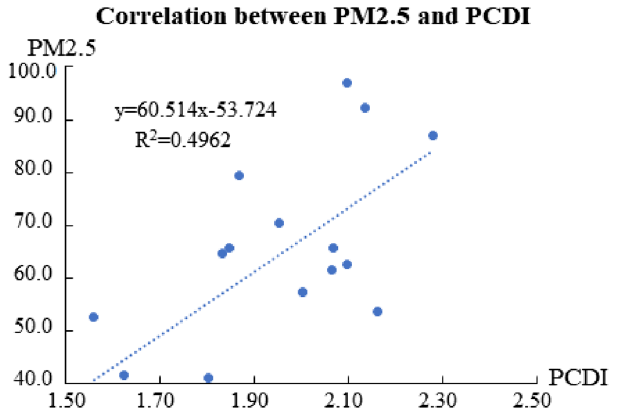
Figure 4. Correlation between PM2.5 and PCDI. This figure shows the correlations between PCDI and PM2.5, and which shows PCDI has high positive correlation with